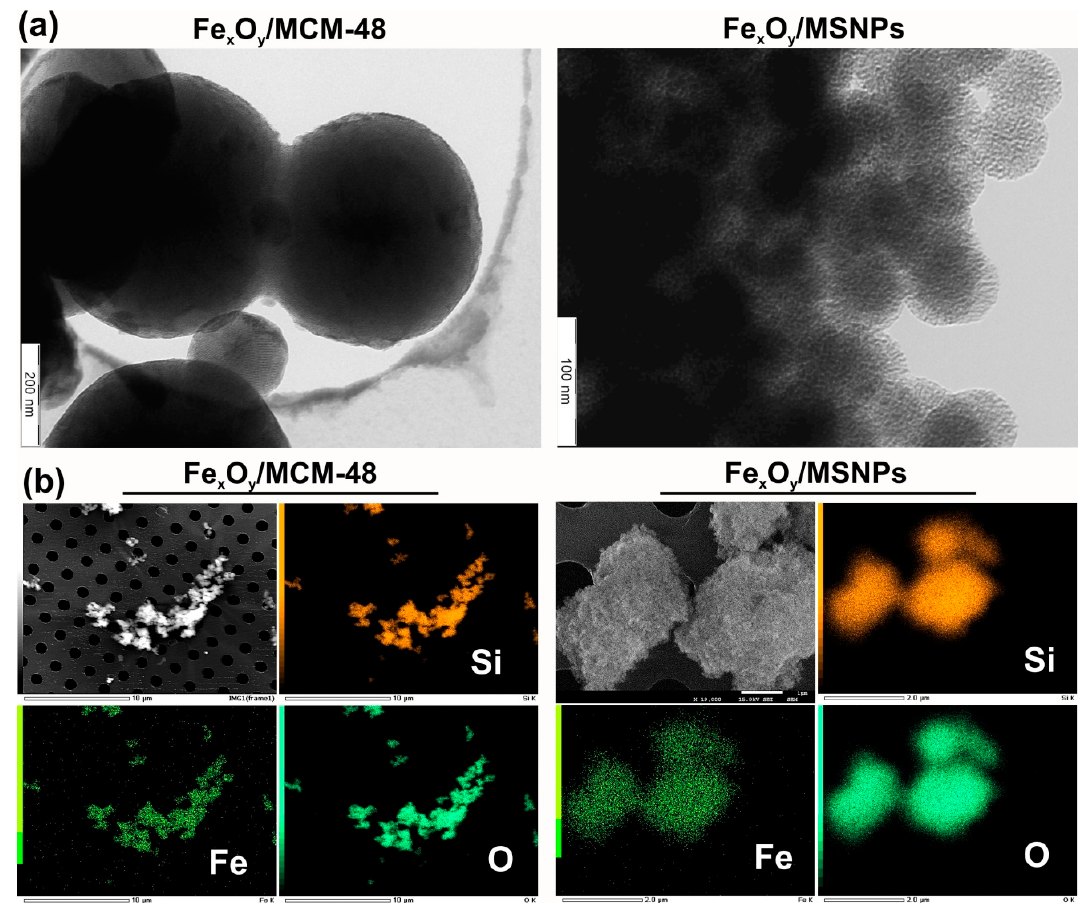
Figure 1. Visualization of produced NPs: ( a ) TEM images of Fe x O y /MCM-48 and Fe x O y /MSNPs catalysts obtained by dry impregnation; ( b ) SEM-EDX mapping of Si, Fe, O elements in the Fe x O y /MCM-48 and Fe x O y /MSNPs samples.